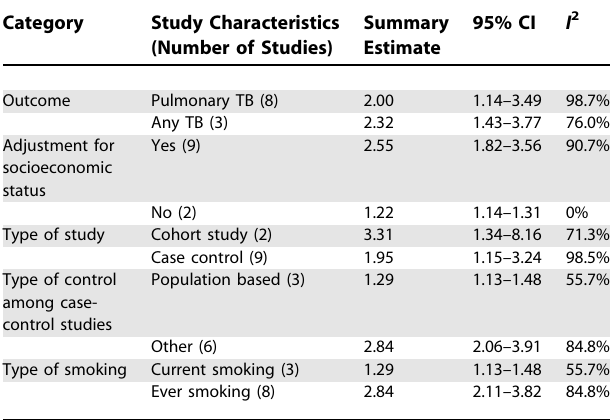
Table 4. Quality Assessment and Subgroup Analysis: